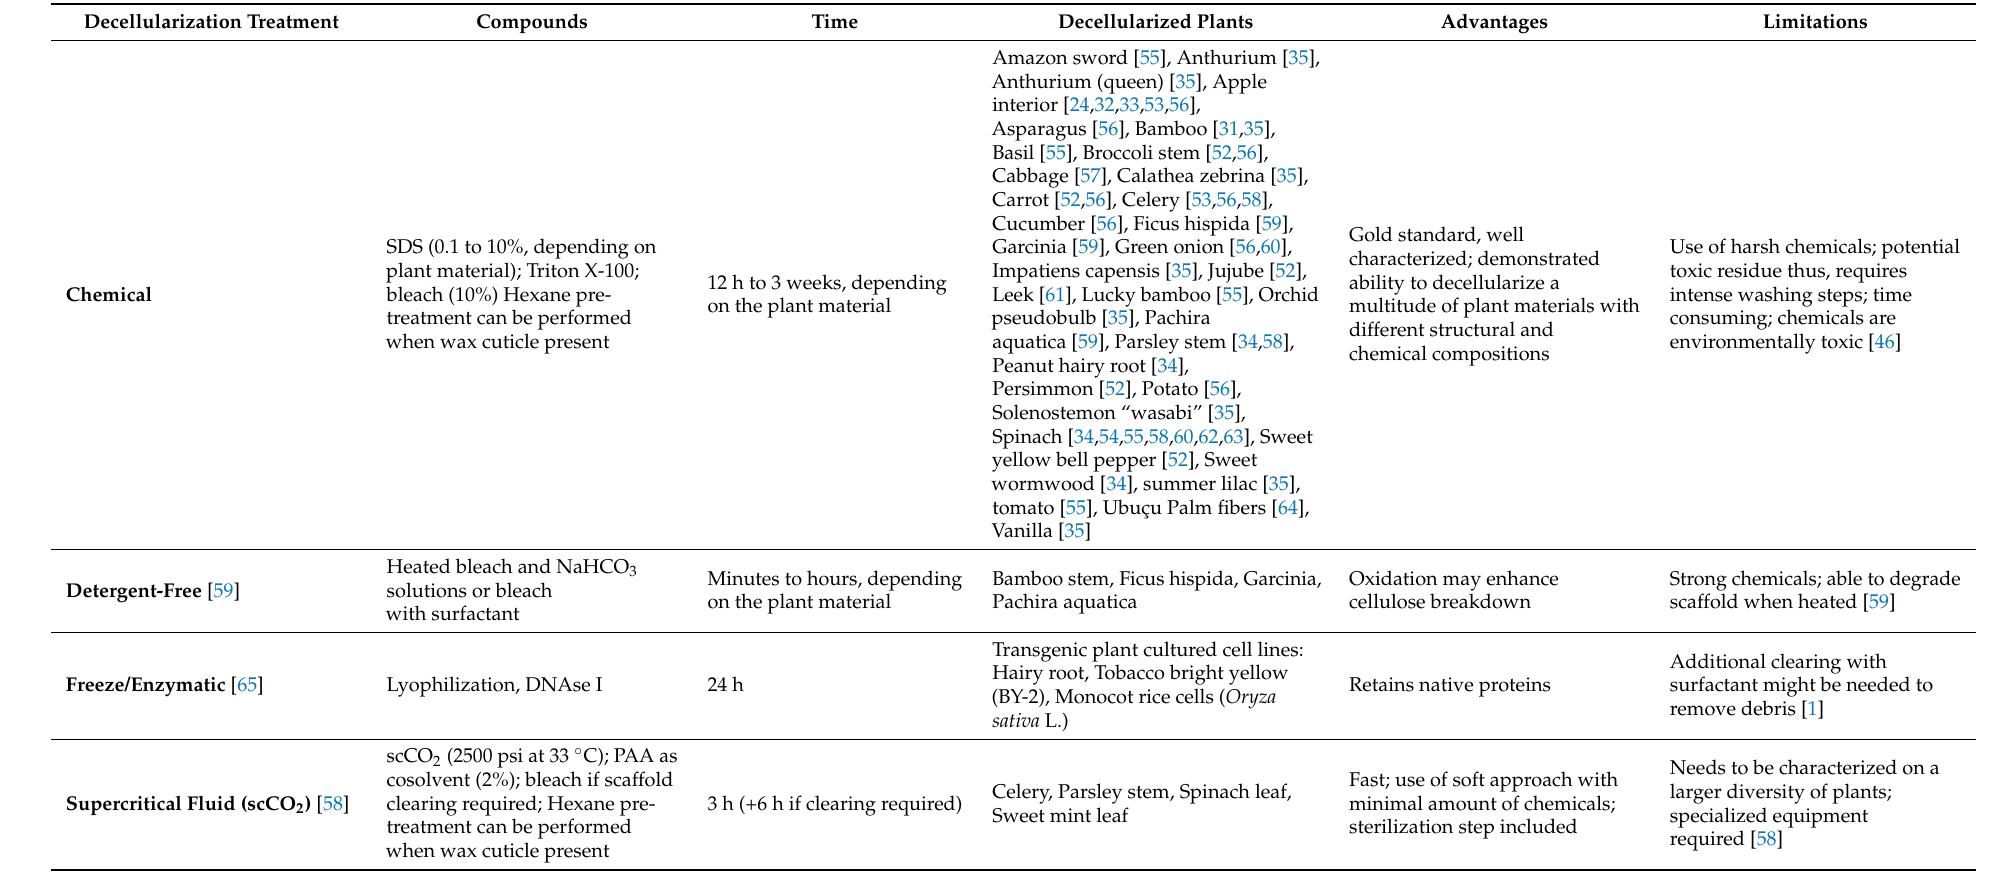
Table 1. Current protocols employed to decellularize plant